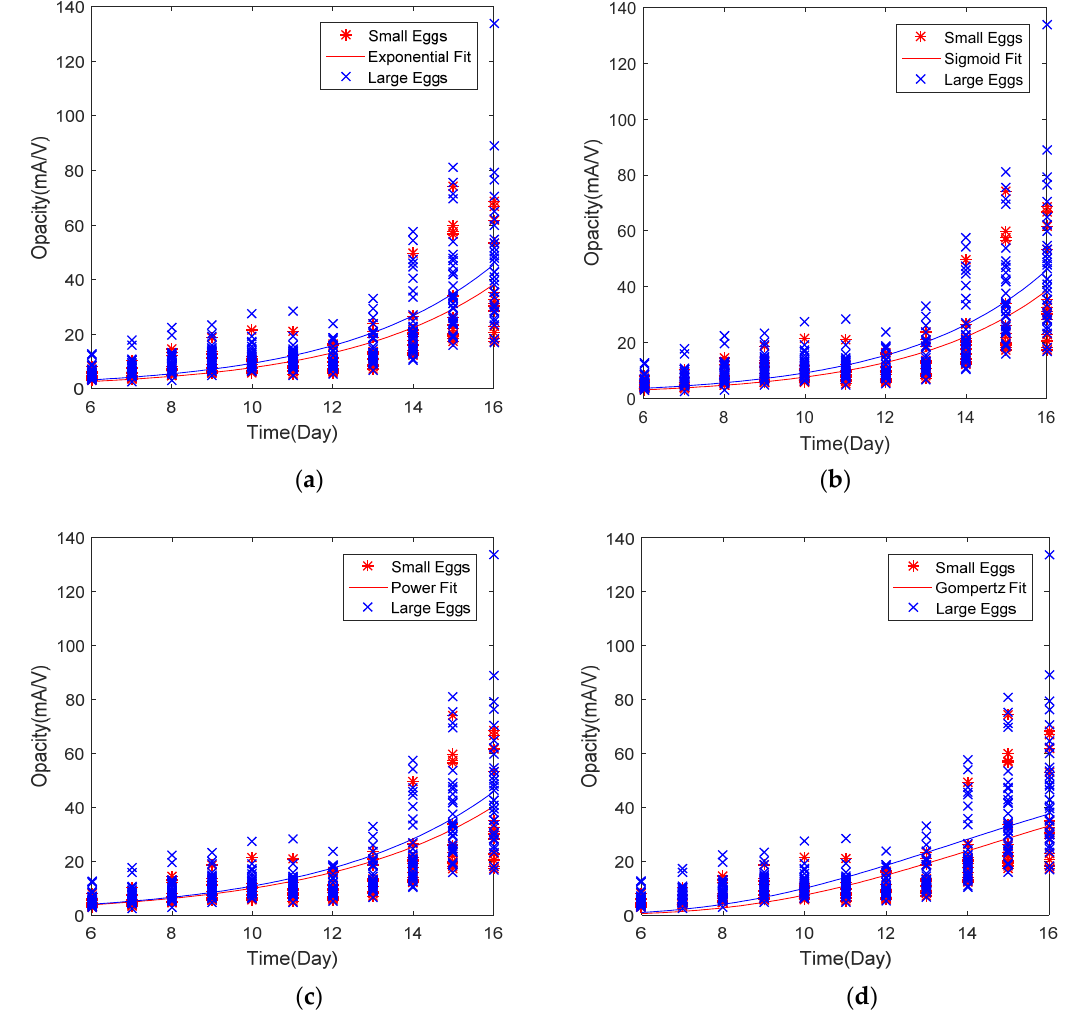
Figure 5. Non-linear least square fitting of opacity curves using various mathematical growth models. ( a ) Exponential fit of opacity data of egg samples, ( b ) Sigmoid fit of opacity data of egg samples, ( c ) Power function fit of opacity values of eggs, ( d ) Gompertz function fitting of incubated egg opacity values for both groups of embryos. The fitting may eliminate the influence of allantois and yolk sac growth during the first half of incubation (formation period).